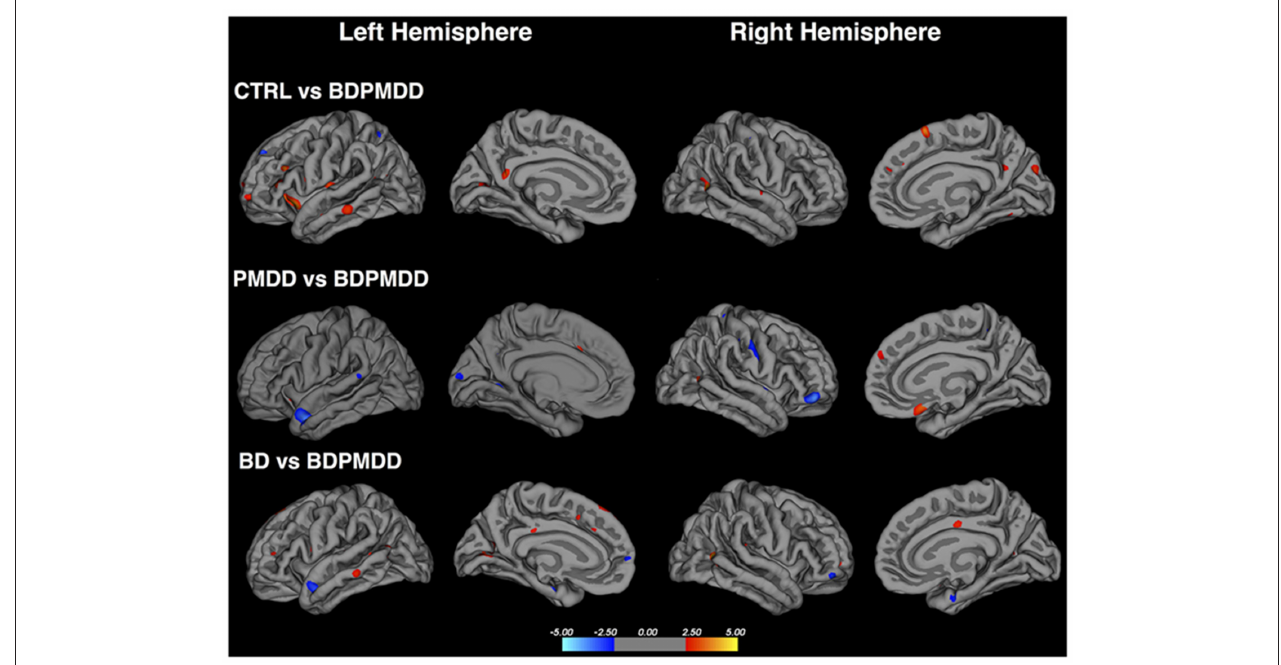
FIGURE 3 | Cortical thickness differences in females with both bipolar disorder and premenstrual dysphoric disorder to a control population, females with premenstrual dysphoric disorder only and females with bipolar disorder only. Red regions indicate higher cortical thickness in the first group compared to females with bipolar disorder and premenstrual dysphoric disorder, while blue regions indicate lower cortical thickness in the first group compared to females with bipolar disorder and premenstrual dysphoric disorder. BD, bipolar disorder; BDPMDD, bipolar disorder with comorbid premenstrual dysphoric disorder; CTRL, healthy controls; PMDD, premenstrual dysphoric disorder. Reproduced with permission from Syan et al.